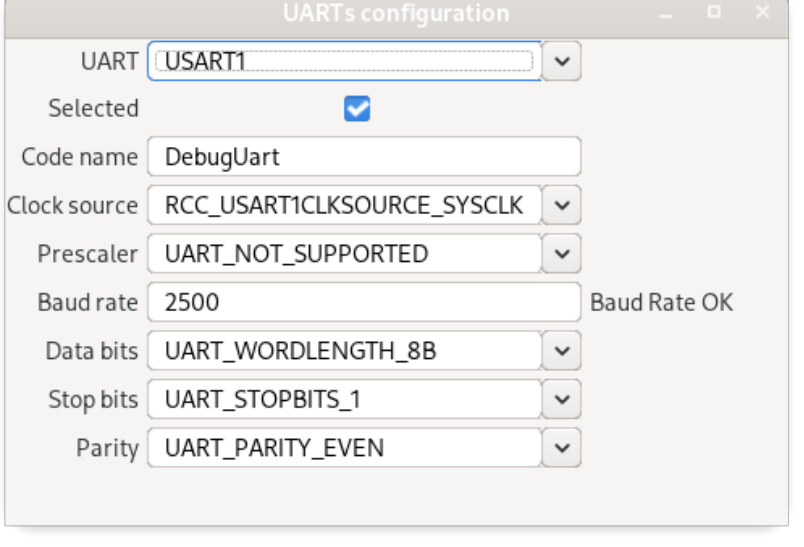
Figure 10. Universal Asynchronous Receiver-Transmitter configuration